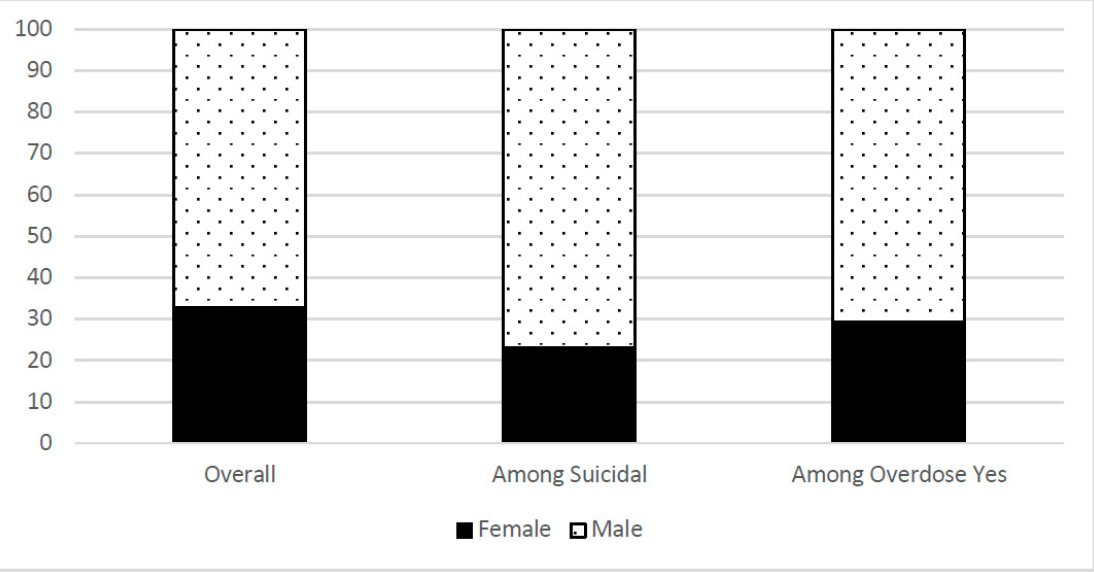
Figure 1. Proportion of Female/Male overall, among those who are suicidal, and among those with an overdose event.